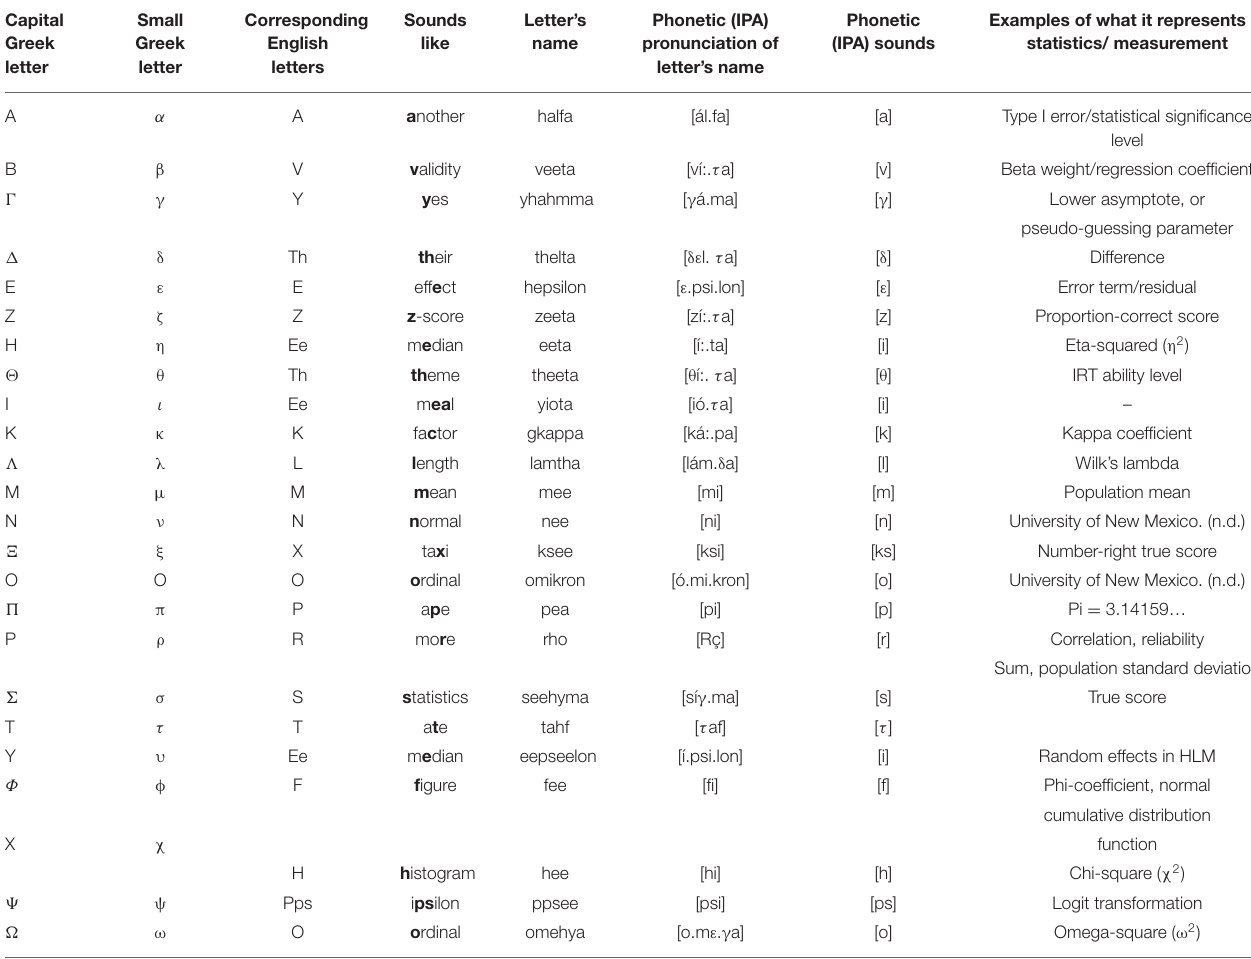
TABLE 1 | Greek letters, their pronunciation, and some representations. Capital